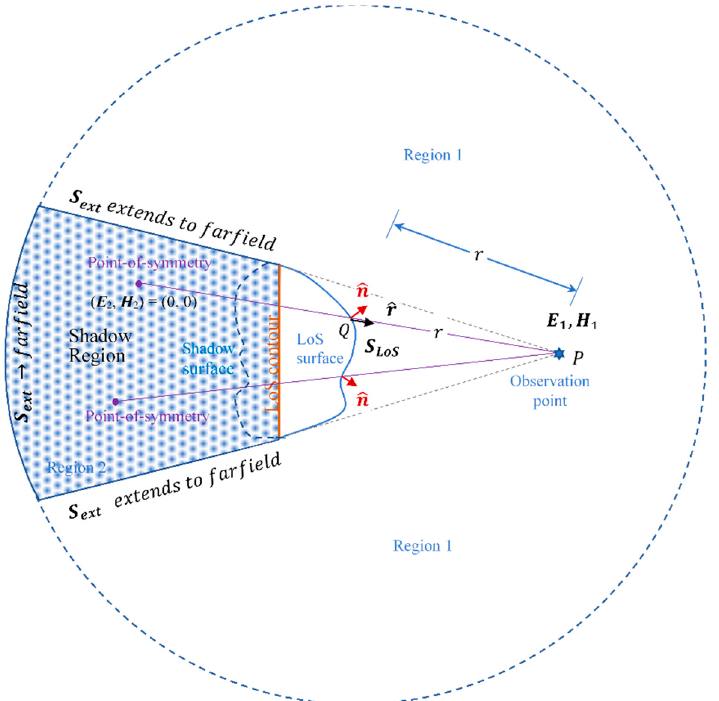
Figure 1. Illustration of the line-of-sight (LoS) equivalent surface, the LoS surface contour, the shadow region, the point-of-symmetry, and the observation point.